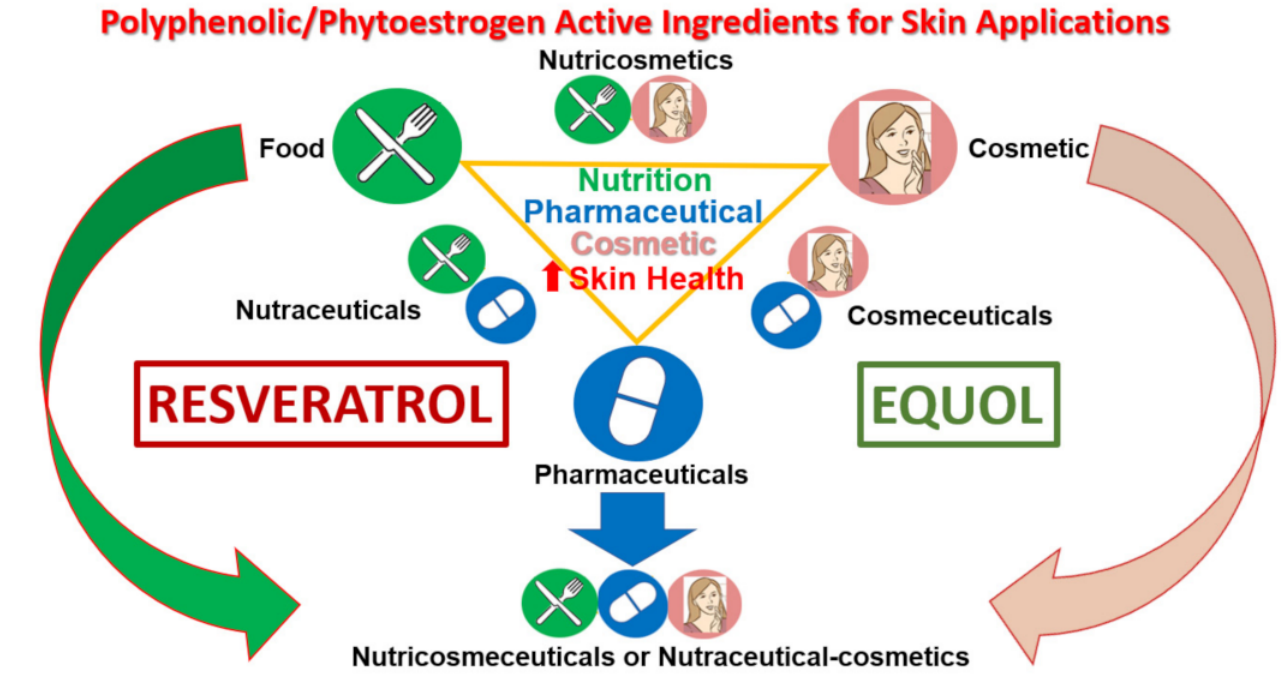
Figure 6. Resveratrol and equol as polyphenolic/phytoestrogens as active ingredients for topical and oral skin applica- tions [101] (use and modified with permission-Elsevier ID